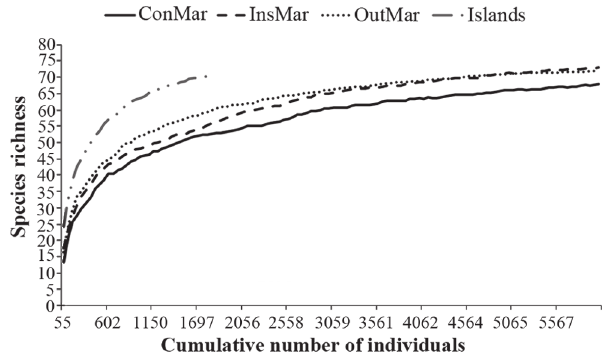
Fig. 4. Extrapolation-based curves of species richness derived from ACE (50 randomizations) for the four strata: (1) Continental Margin - ConMar (n = 120 samples; 4,690 individuals), (2) Insular Margin - InsMar (n = 120; 7,806 indiv.), (3) Outer Margin - OutMar (n = 120; 5,559 indiv.), and (4) Islands (Alcatrazes, Búzios and Vitória) (n = 36; 2,330